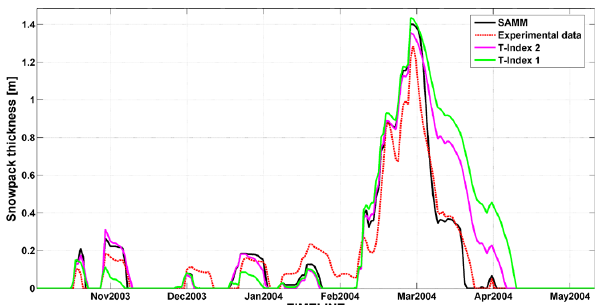
Fig. 8. Comparison between a temperature index model, an im- proved temperature index model, SAMM and experimental data for the period November 2003–May 2004 registered by Febbio station.